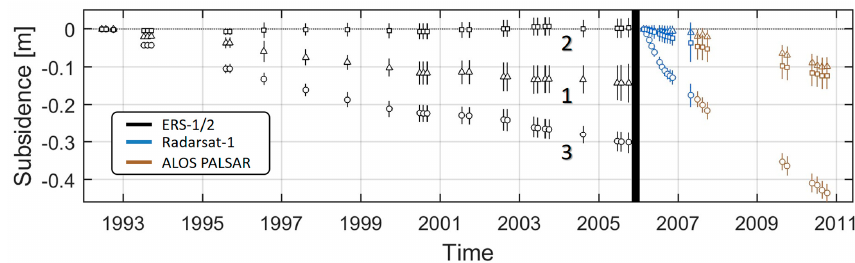
Figure 6. Subsidence measured by InSAR at each of three locations on Augustine Volcano’s North Flank. The data points (labeled 1, 2, and 3 and indicated by different symbols) correspond to locations shown in Figure 5c. Error bars indicate the precision of the measurements and points are color coded by satellite. Bold vertical bars represent dates of eruptions. Vertical bar represents the 2006 eruption.